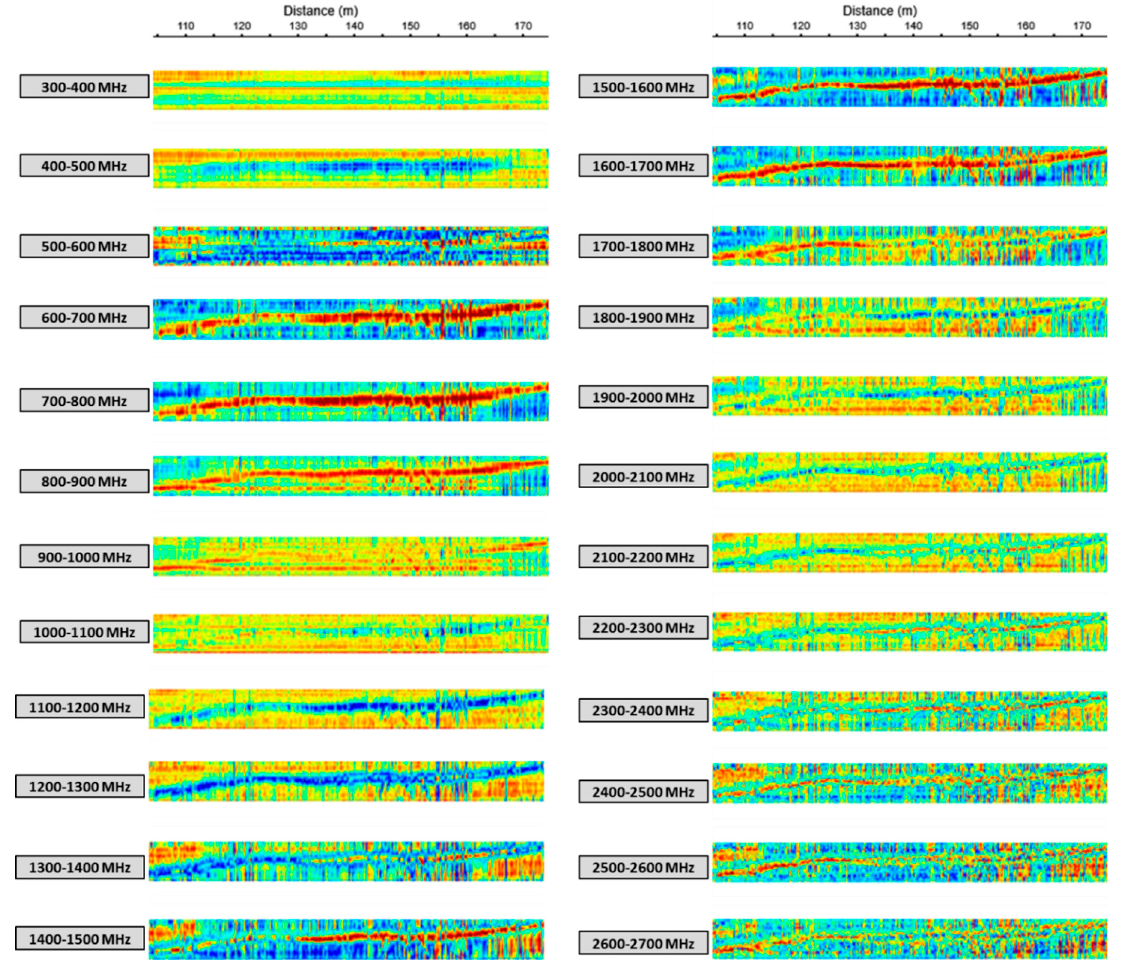
Figure 11. GPR slice with varying frequency, highlight on Area 2.